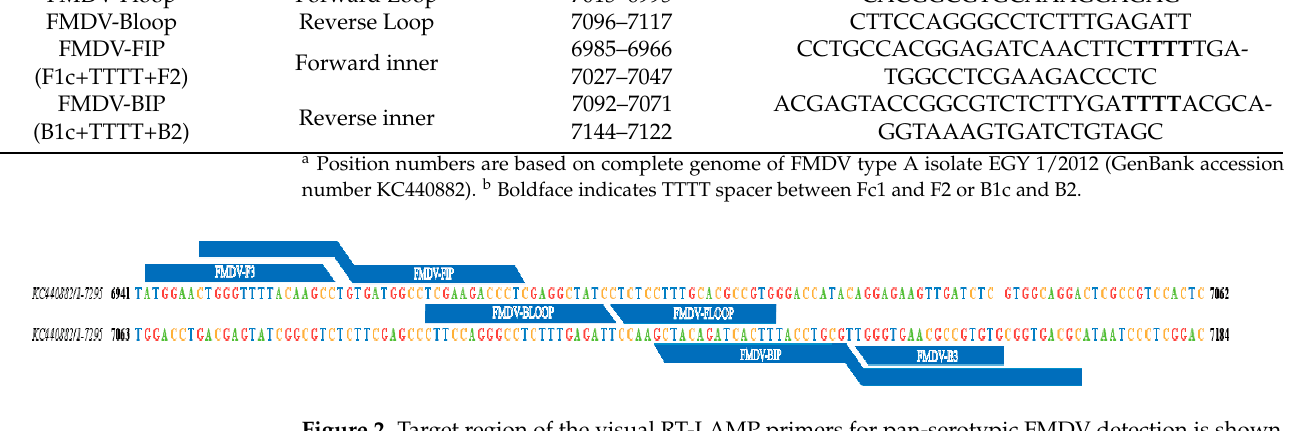
Table 2. The primer sequences for the visual RT ‐ LAMP for pan ‐ serotypic FMDV detection.